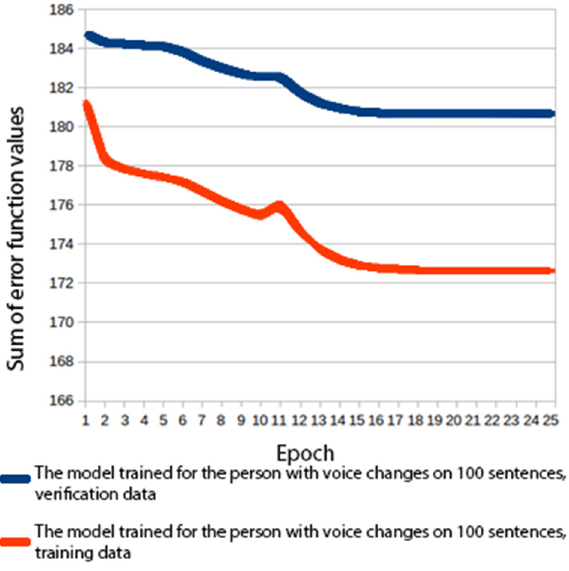
Figure 6. Error function values for a voice trained on 100 sentences.